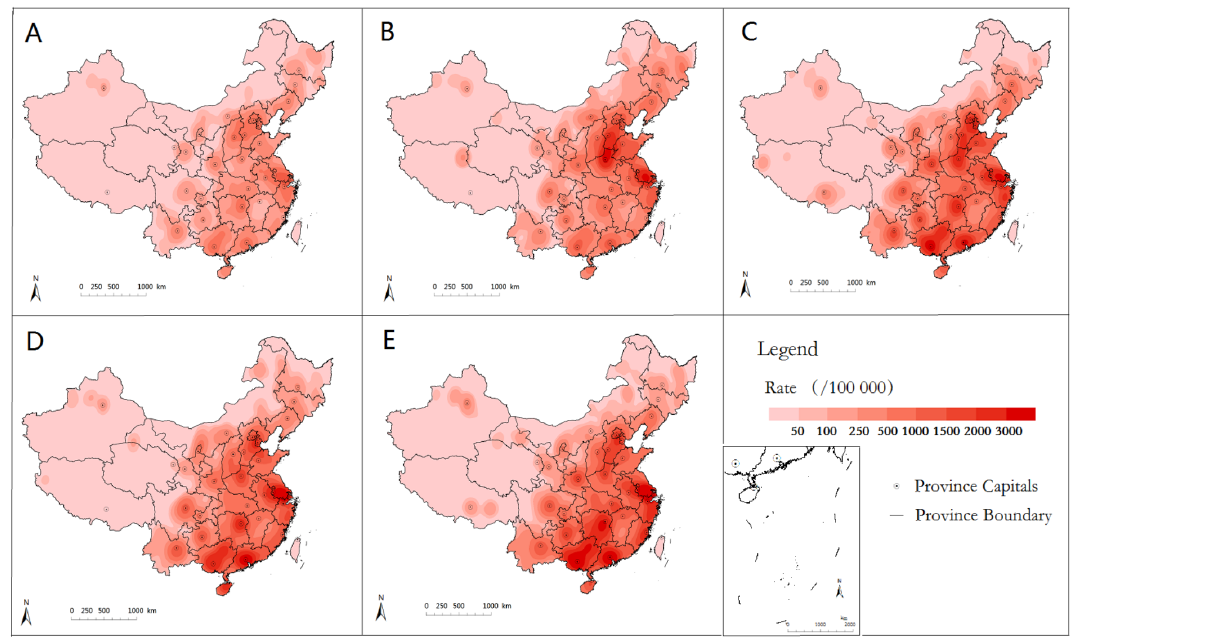
Fig 2. Yearly kernel density map of HFMD incidence in mainland China 2008 – 2012